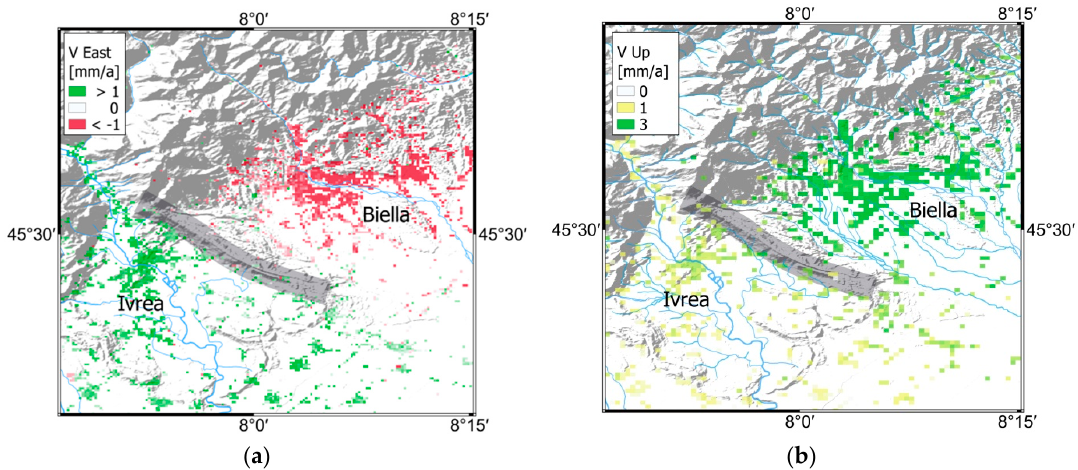
Figure 9. East ( a ) and vertical ( b ) velocity components between the cities of Ivrea and Biella placed along the border between the Po Plain and the Eastern Piedmont Alps. The boundary that separates the two kinematic zones that run along the morainic ridge is represented by a light grey line.